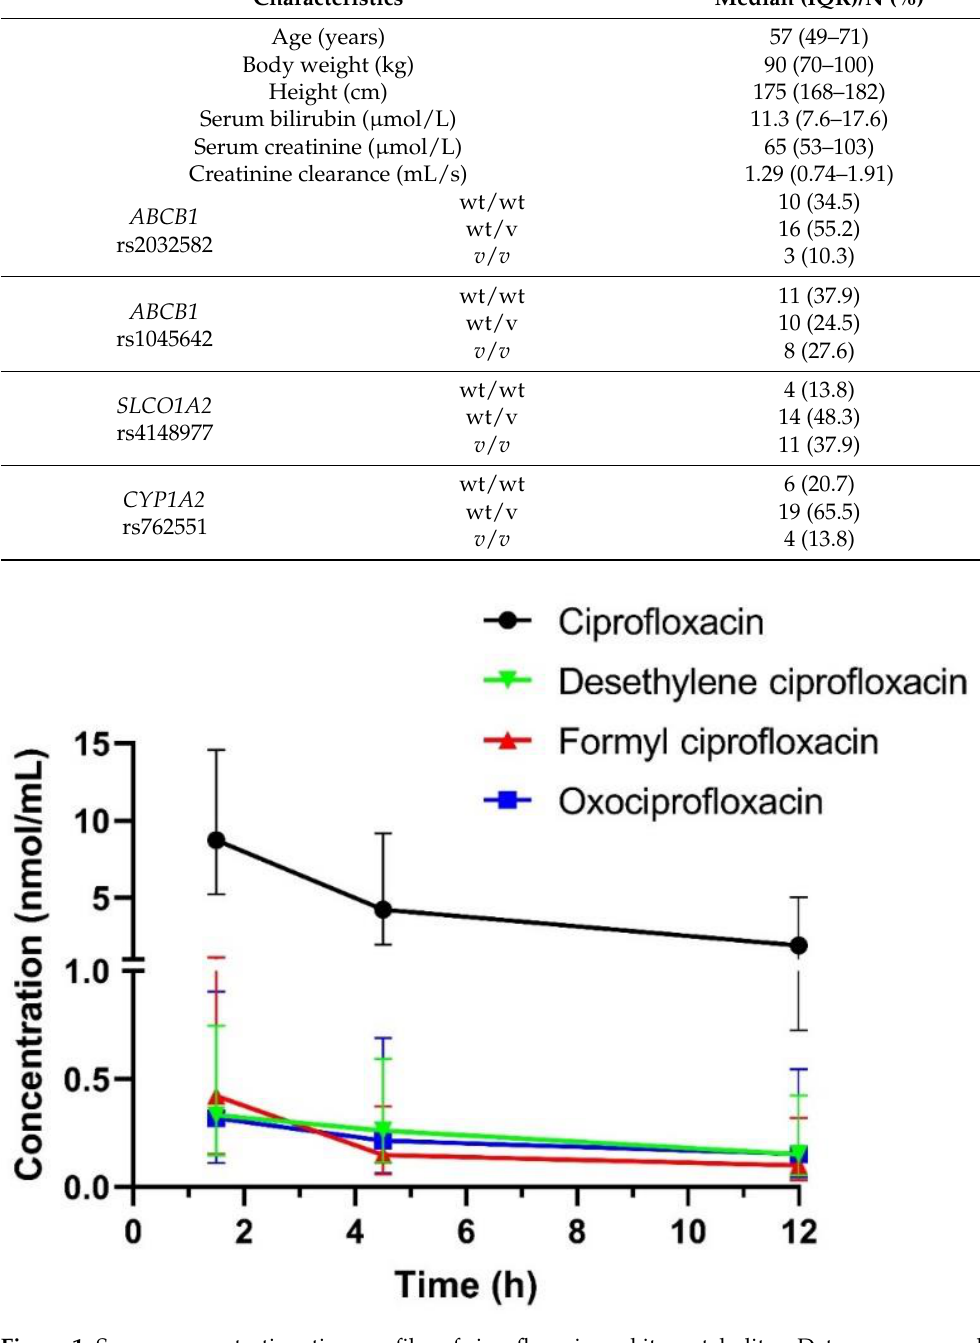
Figure 1. Serum concentration–time profiles of ciprofloxacin and its metabolites. Data are expressed as geometric mean ± SD.